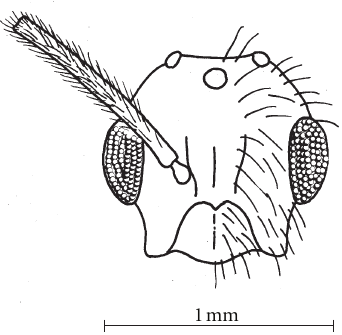
Figure 9: Camponotus